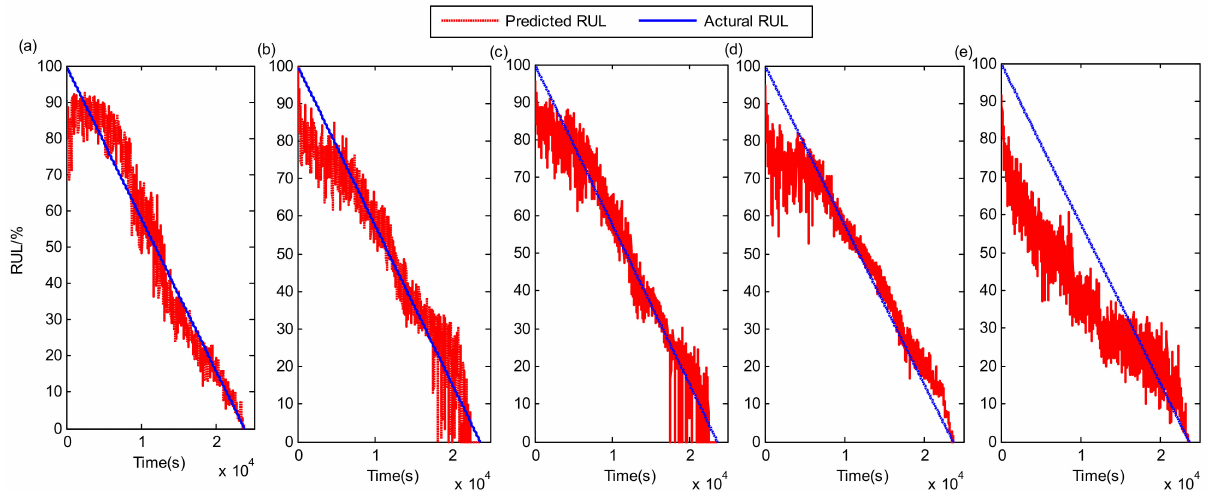
Figure 18. PHM 2012 bearing1_3 RUL prediction results of different comparison methods. ( a ) DSCN; ( b ) MsDCNN; ( c ) CBLSTM; ( d ) ConvLSTM; ( e )